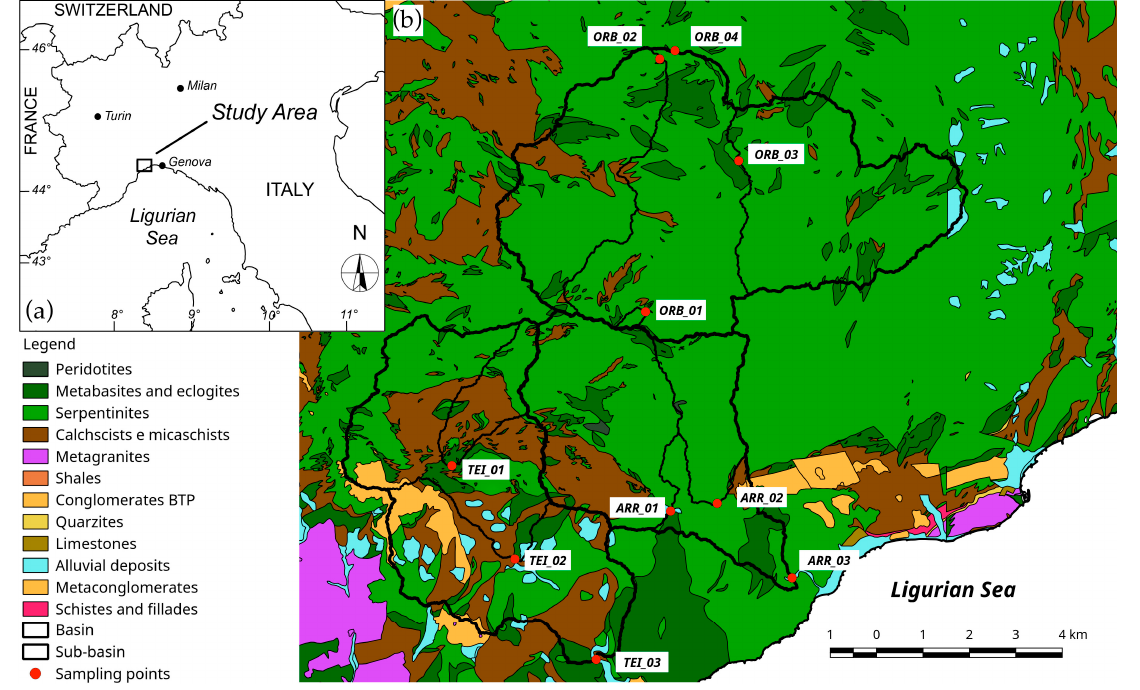
Figure 1. ( a ) Location of the study area; ( b ) geo-lihological map, simplified from the litholgical map of Regione Liguria [38].